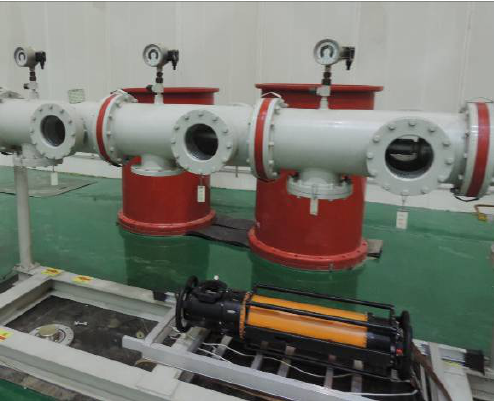
Figure 7. The experimental model.